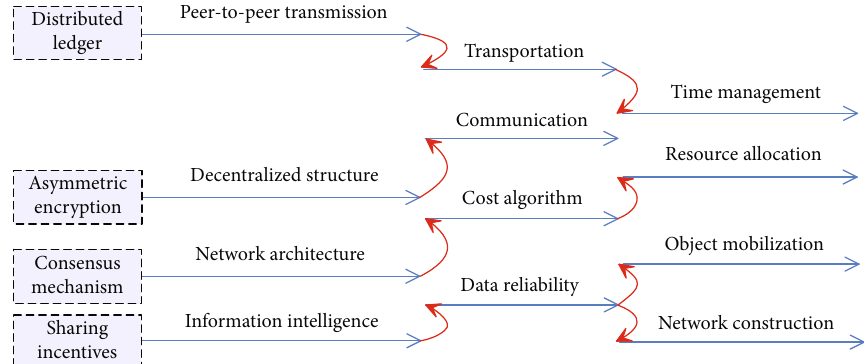
Figure 2: Standard management methods for multiparty collaborations in public administration and resource allocation based on blockchain and structured occupational